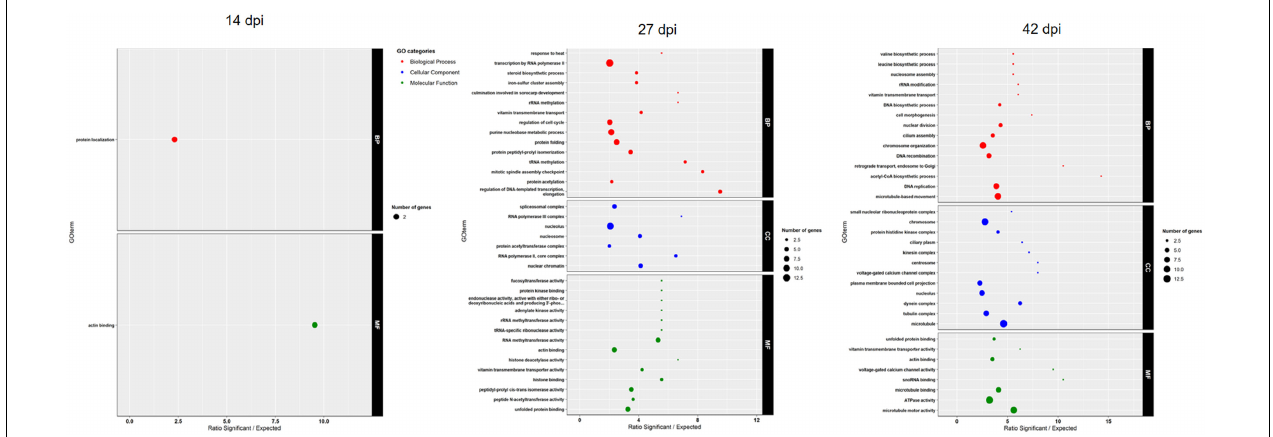
FIGURE 3 | GO enrichment on DEGs lists according to the nitrogen effect at each time-course point. DEGs, differentially expressed genes; dpi, days post-inoculation.